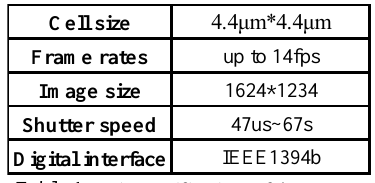
Table 1 Main specifications of the